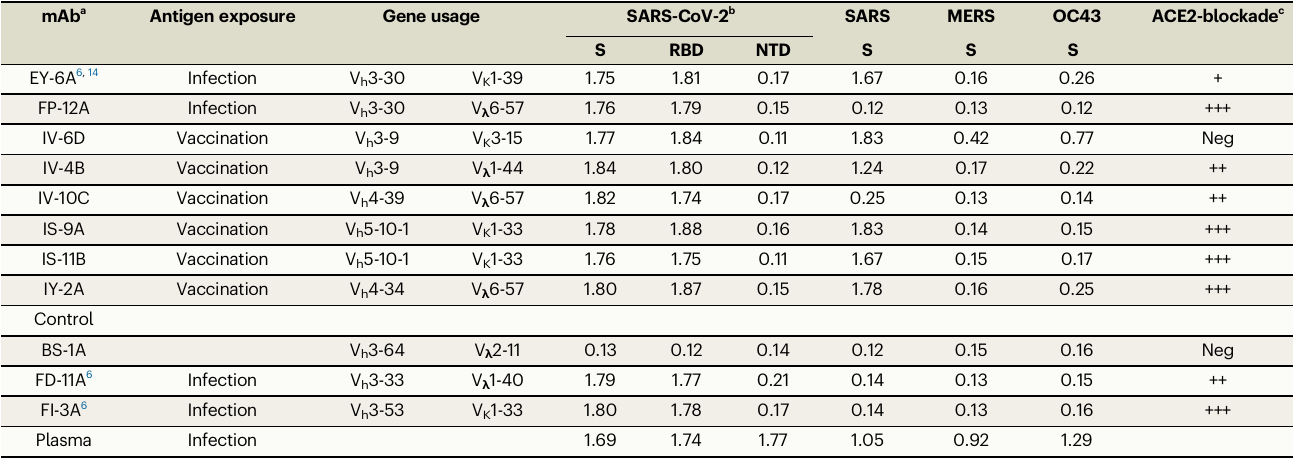
Table 1 | Antigenic speci fi city and cross-reactivity of class 4 anti-SARS-CoV-2 RBD neutralizing human antibodies mAb a Antigen